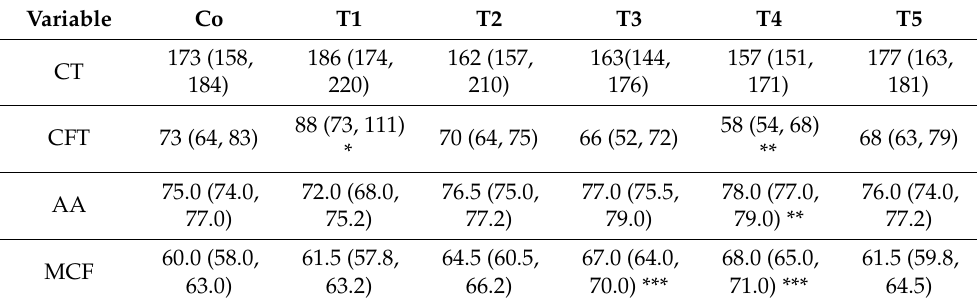
Table 4. Development of CT, CFT, AA, and MCF values in INTEM in high-risk patients during pregnancy, after the postpartum period, and in the control group. Data are presented in the form of medians and interquartile ranges.